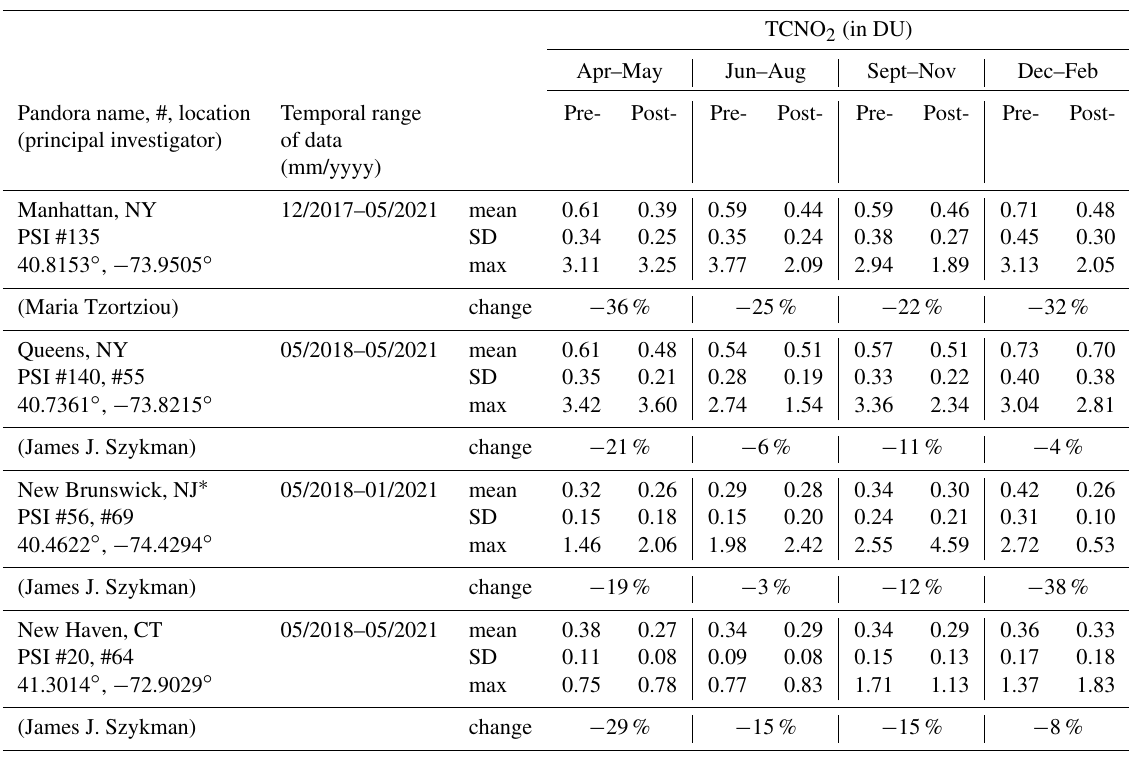
Table 1. Pandora sites (including names of local principal investigator (PI)), and mean, standard deviation (SD), and maximum (max) total column NO 2 (TCNO 2 ) amounts (based on half-hour averages) measured before (pre-) and after (post-) the COVID-19 lockdown in New